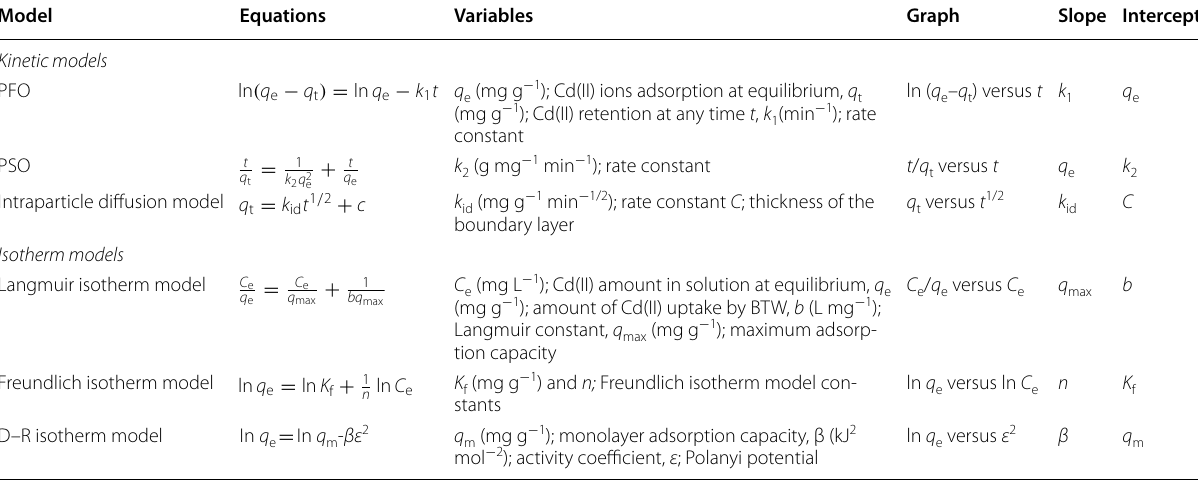
Table 2 Equations and variables of kinetics and isotherms